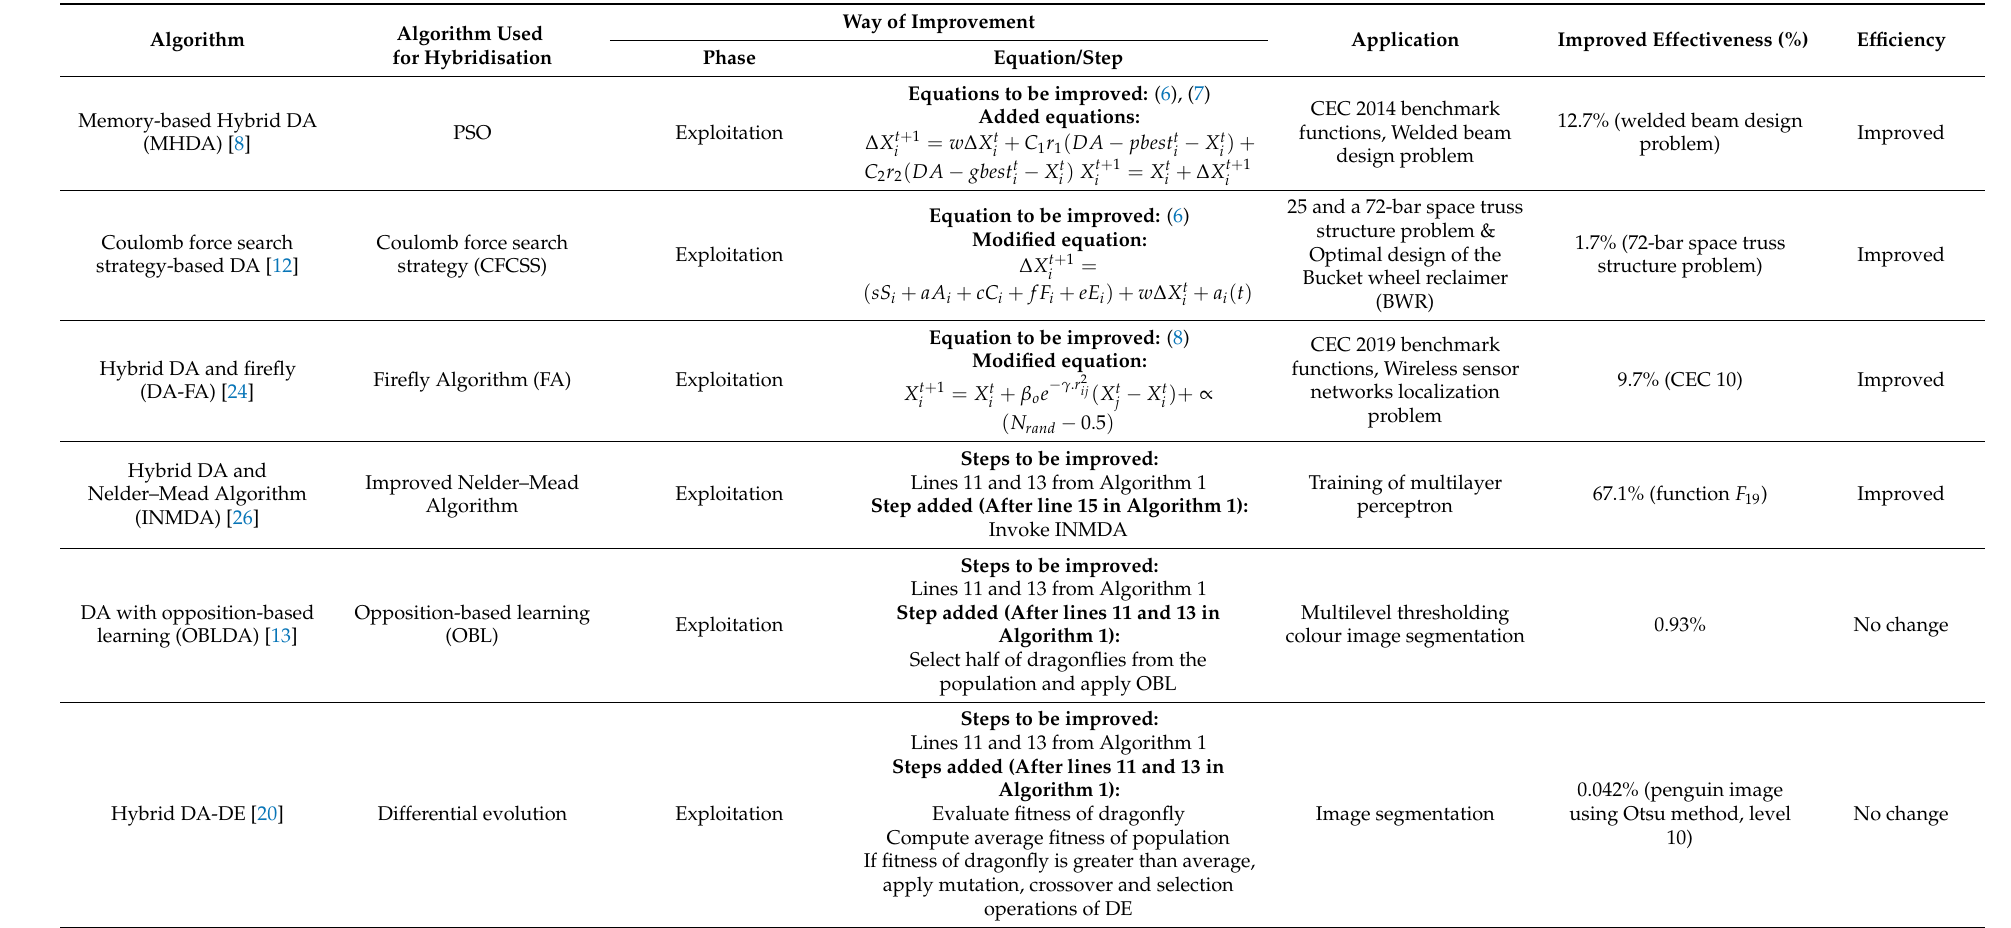
Table 2. Hybrids of DA which improve its effectiveness by improving